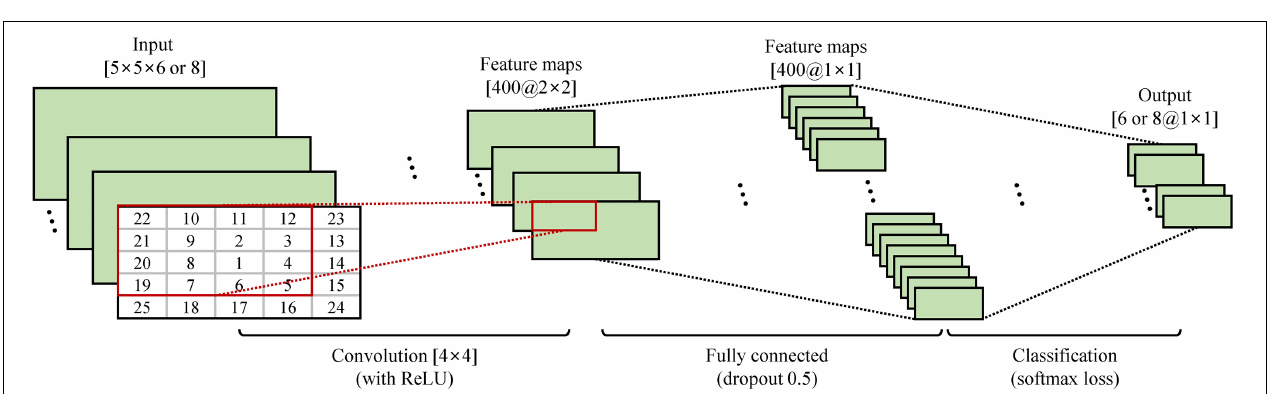
FIGURE 4 | Architecture for PCA–CNN method. Twenty-five PCs were extracted via PCA and reshaped and rearranged into a 2D matrix. Then, two-dimensional matrix was convolved with 400 filters of size 4 × 4 and 2 × 2 and fully connected for classification.